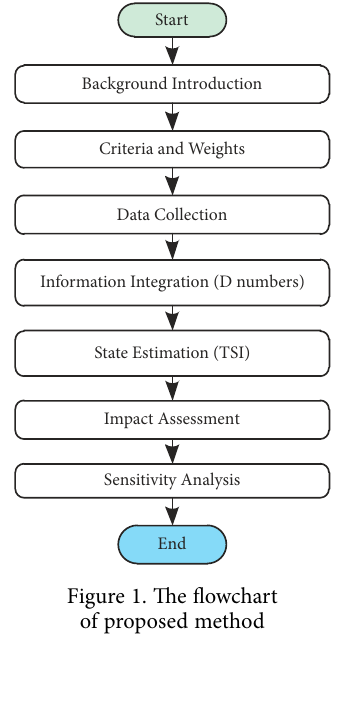
Figure 1. The flowchart of proposed